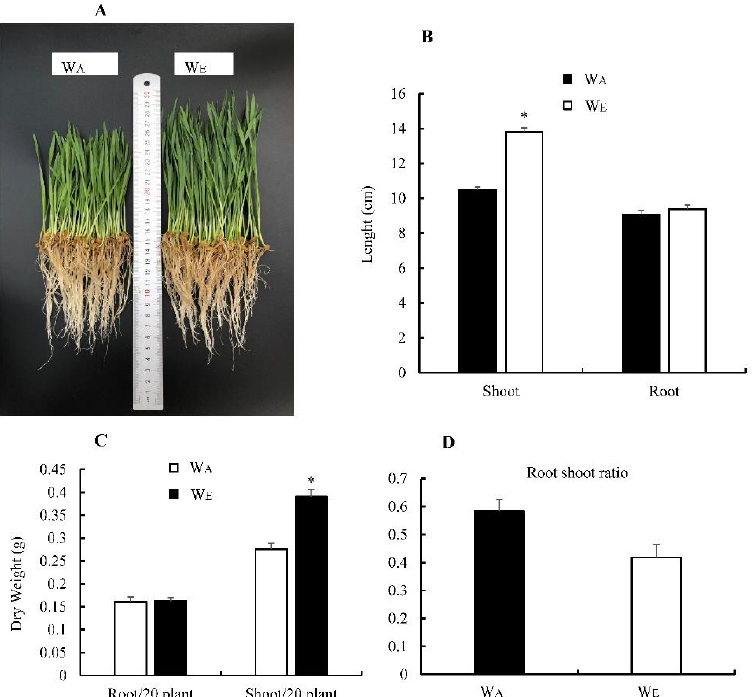
Figure 2. Length ( A , B ); root and shoot weight ( C ); and root-to-shoot ratio ( D ) of wheat at aCO 2 and